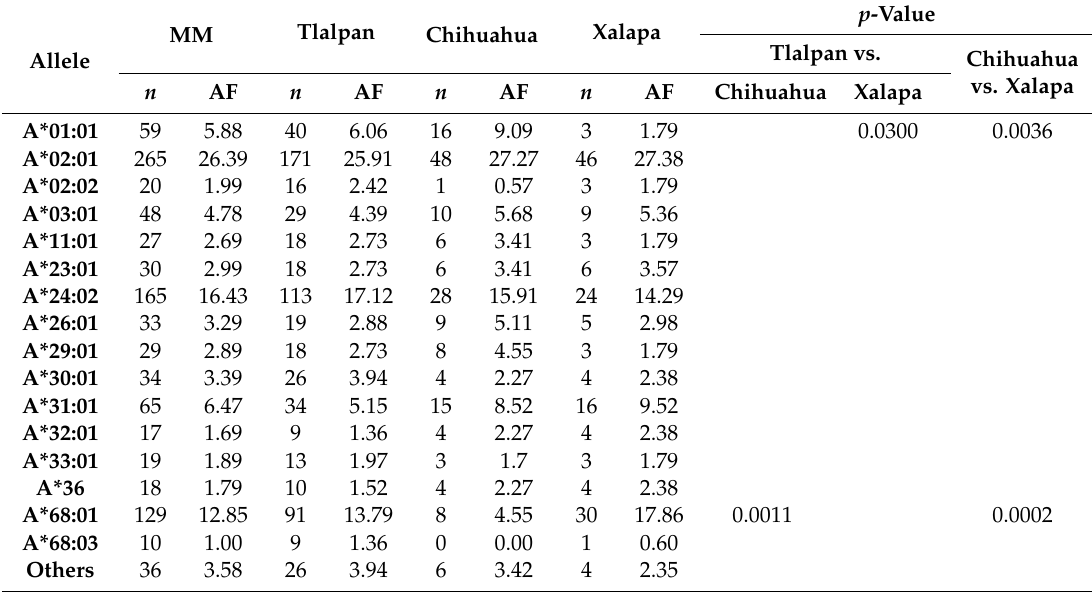
Table 2. HLA-A allele frequency from Mexico: Tlalpan, Chihuahua, and